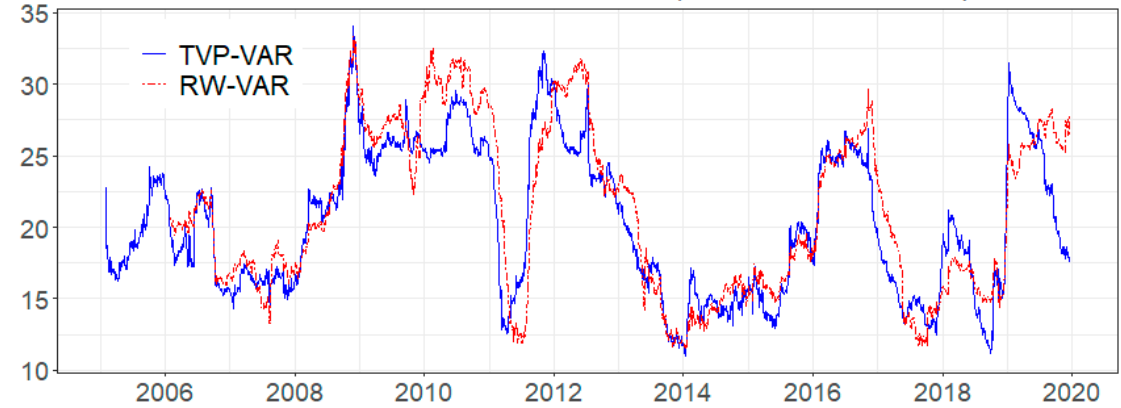
Figure 5. Dynamic total return connectedness (TVP-VAR vs. VAR). Note: the horizontal axis is the timeline; the vertical axis is the connectedness.